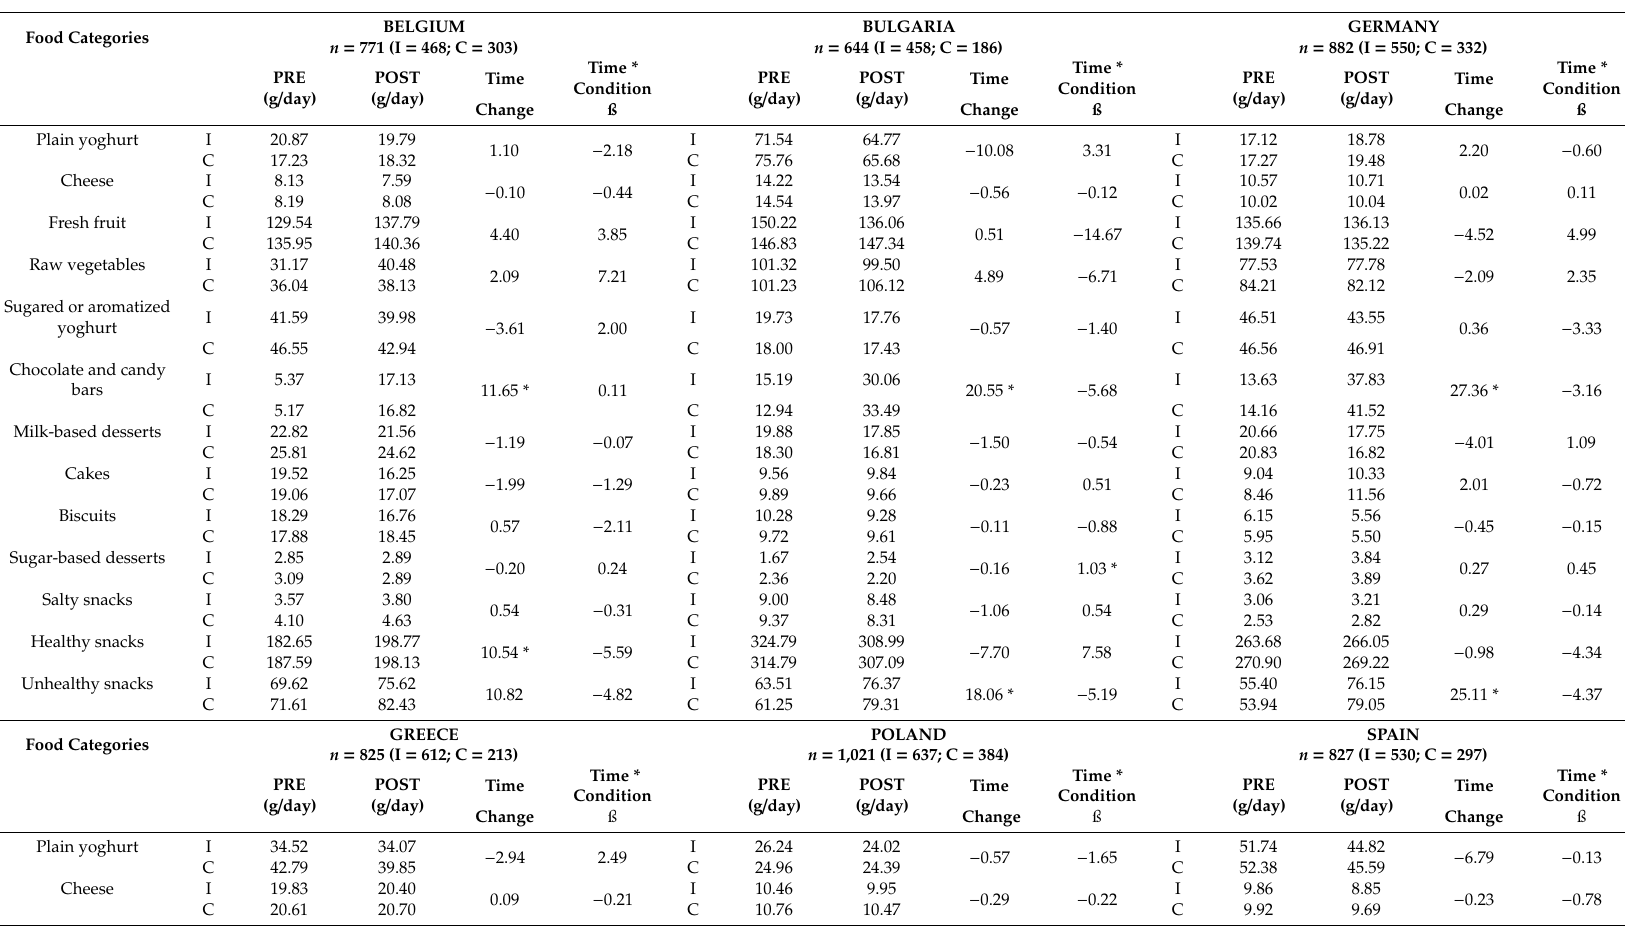
Table 4. Time and interaction e ff ects for the di ff erent food categories for the six intervention countries separately (adjusted for age and sex). Food